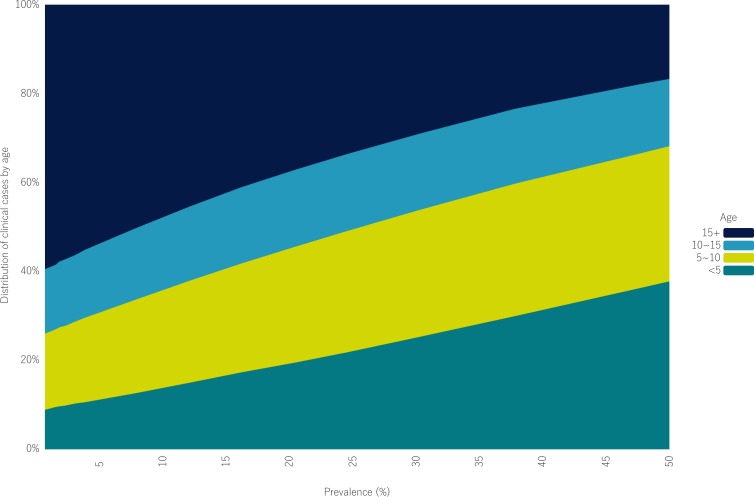
Clinical age profiles for different endemic levels.Shows how the distribution of malaria clinical cases across age bins changes with increasing all-age true prevalence.